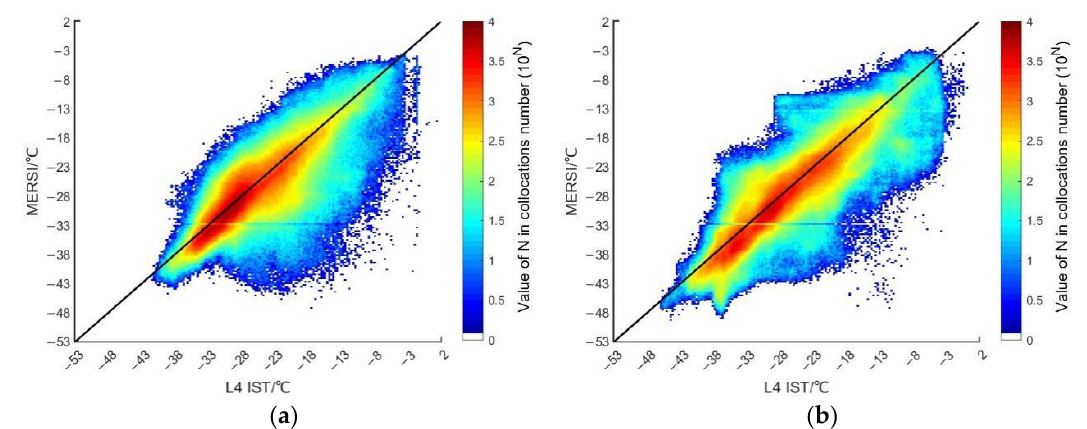
Figure 13. ( a ) Scatter plot diagram of L4 IST and MERSI IST data in January. ( b ) Scatter plot diagram of L4 IST and MERSI IST data in February.